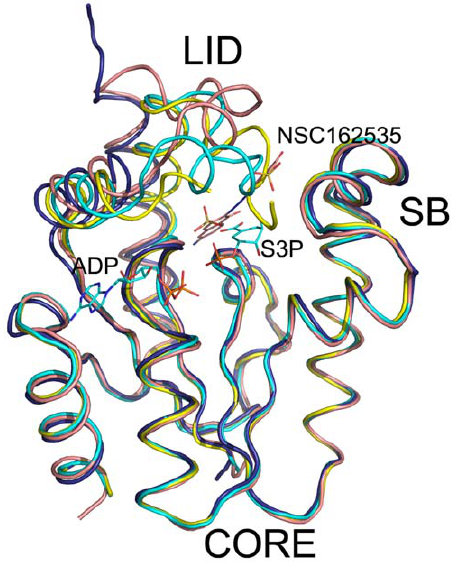
Figure 2. Superposition of four HpSK structures. The following structures are shown: HpSK ? dimer ? SO 4 (blue), HpSK ? shikimate ? PO 4 (1ZUI) (yellow), HpSK ? S3P ? ADP (cyan), and E114A ? 162535 (pink). These structures show homologous folds but a flexible LID segment.